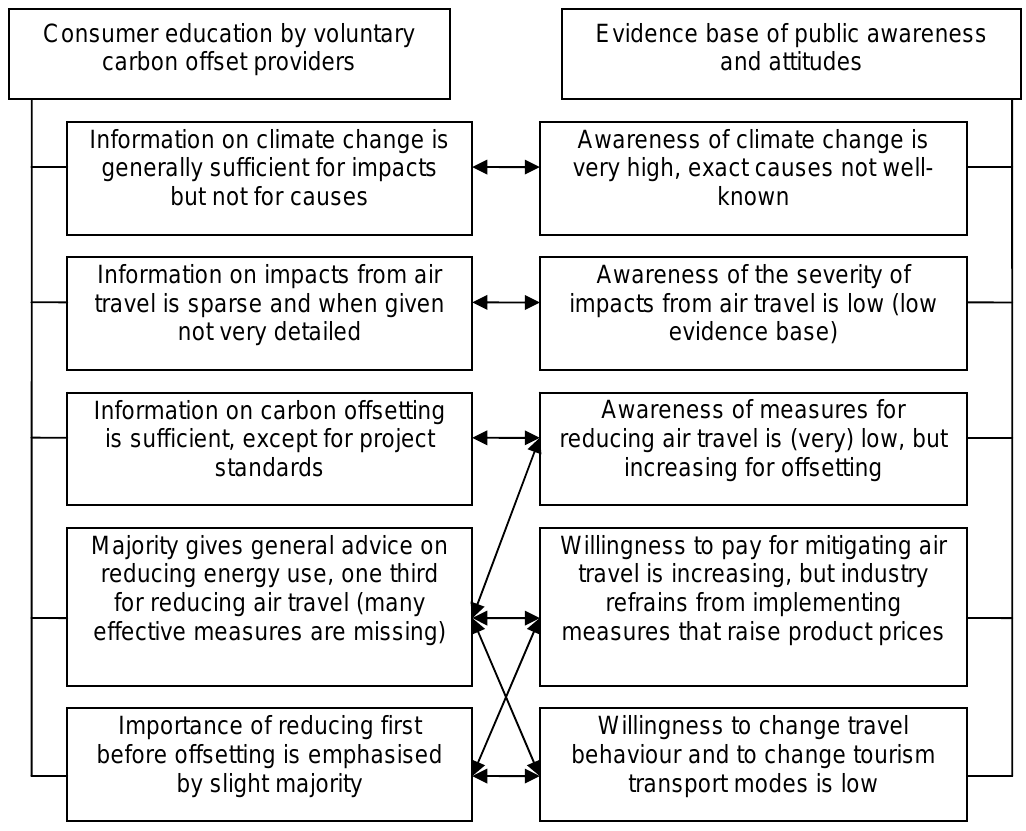
Figure 3. Comparison of results of attitude review and provider